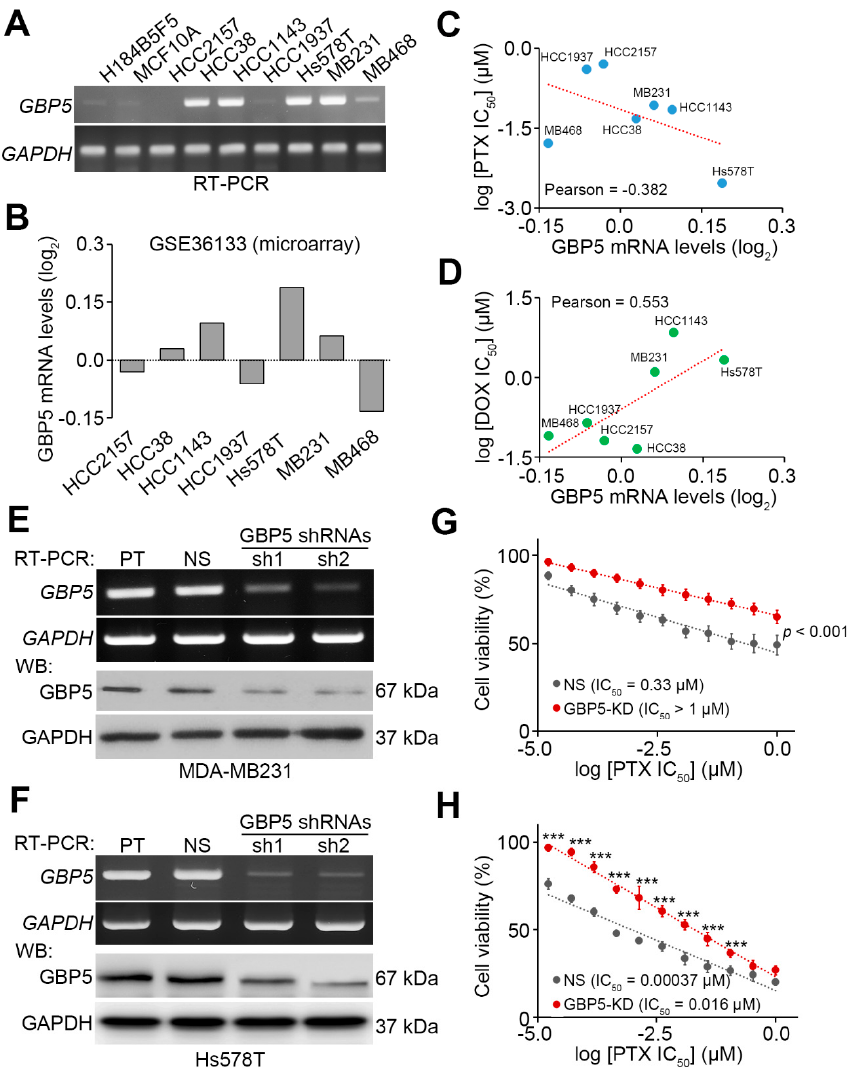
Figure 3. GBP5 knockdown desensitizes TNBC cells to paclitaxel treatment. ( A ) The mRNA levels of GBP5 and GAPDH detected by RT-PCR in a panel of normal mammary epithelial cell lines H184B5F5/M10 and MCF10A, and TNBC cell lines HCC2157, HCC38, HCC1143, HCC1937, Hs578T, MDA-MB231 (MB231) and MDA-MB468 (MB468). ( B ) GBP5 mRNA levels in the indicated TNBC cell lines from GSE36133 dataset. ( C , D ) Scatter plots for the correlation of GBP5 mRNA levels with paclitaxel (PTX, C ) and doxorubicin (DOX, D ) IC 50 concentrations in the tested TNBC cells lines. Statistical significance was analyzed by Pearson correlation test. ( E , F ) The mRNA and protein levels of GBP5 and GAPDH detected by RT-PCR and Western blot (WB) analyses, respectively, in parental (PT) MDA-MB231 ( E )/Hs578T ( F ) cells and MDA-MB231/Hs578T cells stably transfected non-silencing (NS) control or 2 independent GBP5 shRNA clones. In A , E and F , GAPDH was used as an internal control of experiments. ( G , H ) Dot plot for cell viability determined from non-silencing control and GBP5-knockdown (GBP5-KD), using sh2 clone, MDA-MB231 ( G )/Hs578T ( H ) cells. Non-parametric Mann–Whitney test was used to estimate the statistical significances. The symbol “***” denotes p <